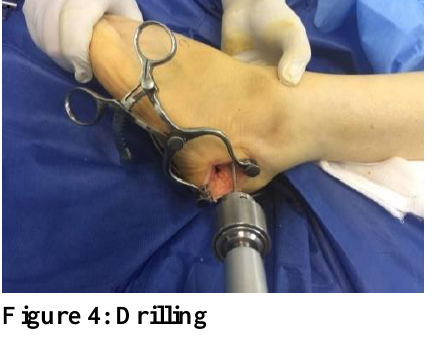
Figure 4: Drilling